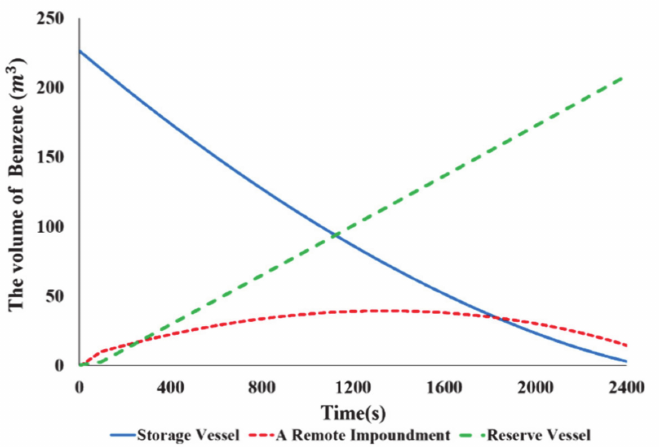
Figure 6. The volume of benzene in the storage vessel, a remote impoundment and a reserve vessel when the leak of the benzene from the storage vessel occurs. The diameter of the leak hole is 4 inch.